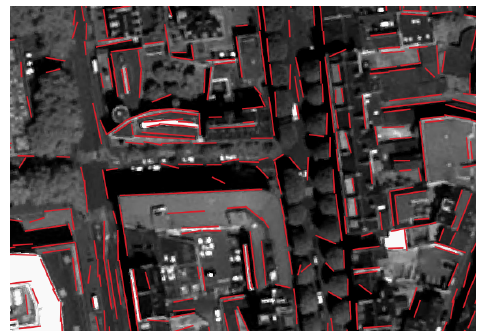
Figure 2. Detected segments on an extract of a PHR image (0.5